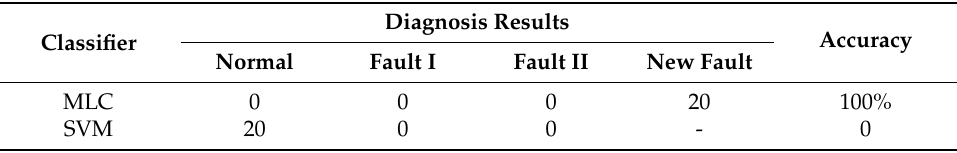
Table 4. Diagnosis results of the new type of fault using MLC and SVM.